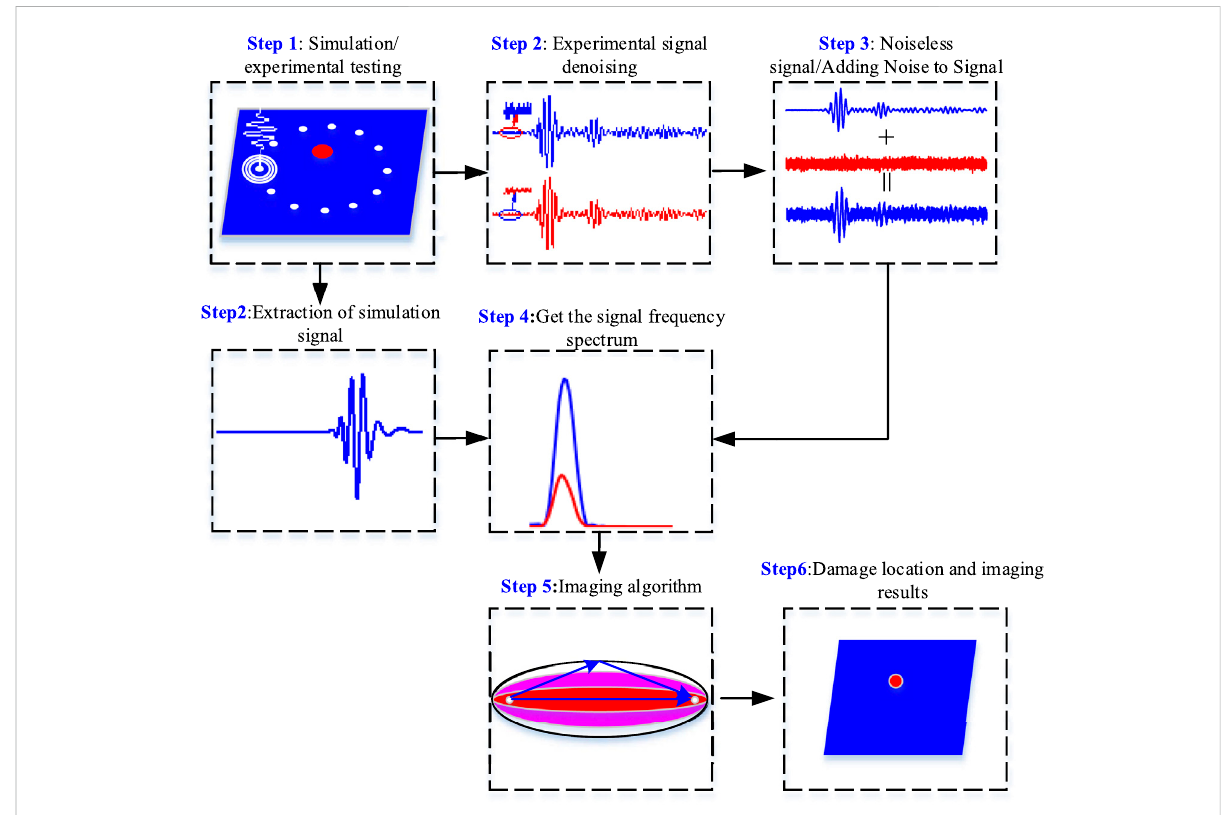
FIGURE 1 Flow chart for damage location and imaging identi fi cation of composite Manuscript Formatting.